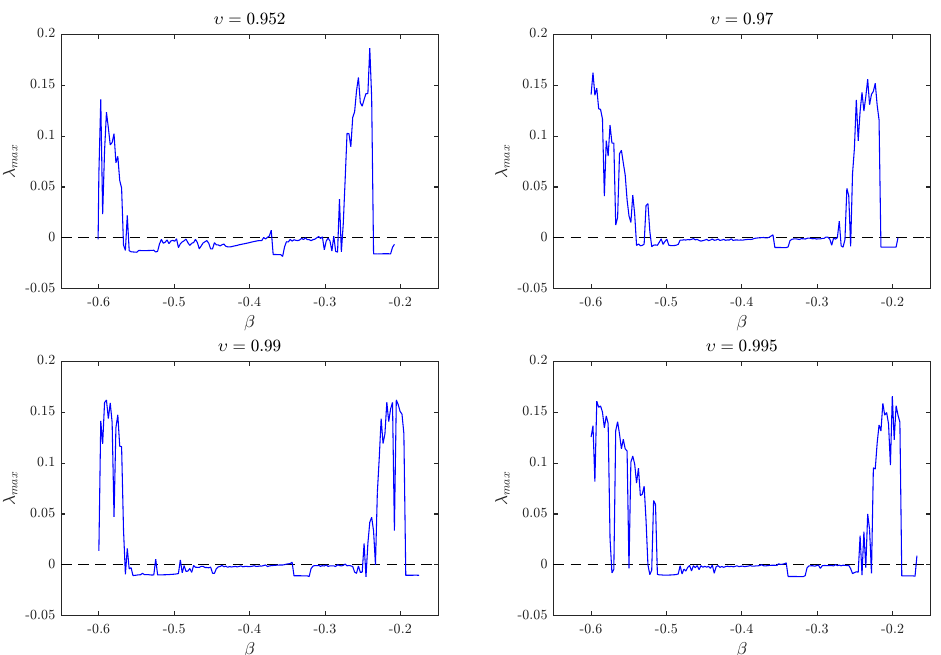
Figure 5. The largest Lyapunov exponent as a function of parameter β for different values of the fractional order.